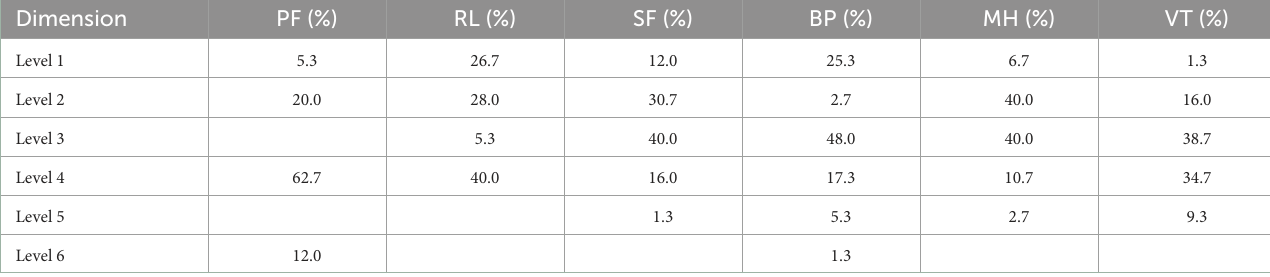
TABLE 2 Frequencies of each level in six dimensions of SF-6D for adult patients with β -thalassemia major ( n = 75).